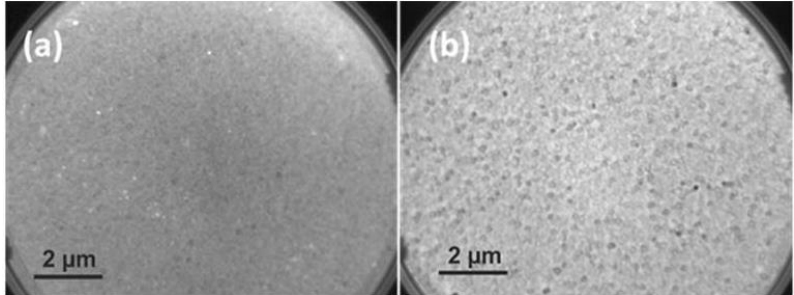
Figure 1. LEEM images of 600 °C ( a ) and 700 °C ( b ) deposited samples, the images were collected at µ m with 5 eV kinetic field of view (FoV) of 12.4 µm with 5 eV kinetic energy. field of view (FoV) of 12.4